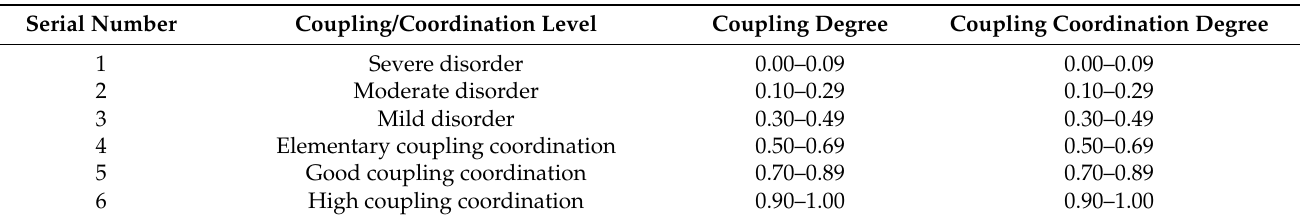
Table 5. Division standard for coupling coordination degree between production land and living land in rural